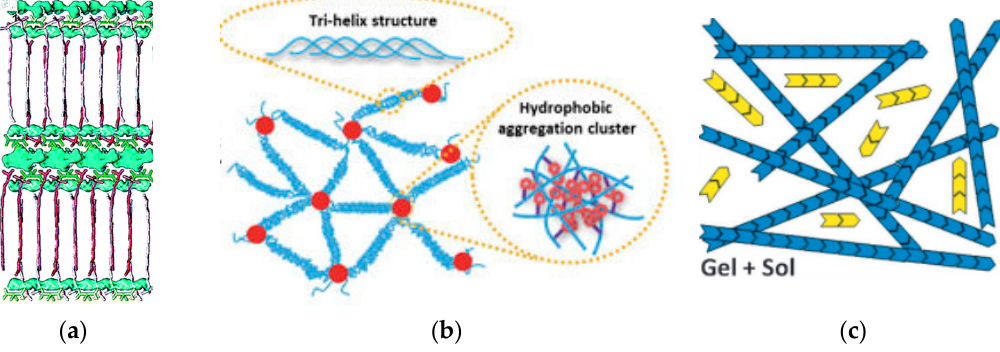
Figure 1. Examples of supramolecular gels are found in three of the four categories of gels defined by Flory [2]: ( a ) category 1: high-order lamellar gels [6]. Adapted with permission from ref [6]. Copyright 2016 Boekhoven et al.; ( b ) category 3: semi-ordered physical networks [7]. Adapted with permission from ref [7]. Copyright 2018 Springer Nature; and ( c ) category 4: disordered particulate gels [5]. Adapted with permission from ref [5]. Copyright 2012 Royal Society of Chemistry; The second category identified by Flory, disordered covalent networks, is not considered to be supramolecular.